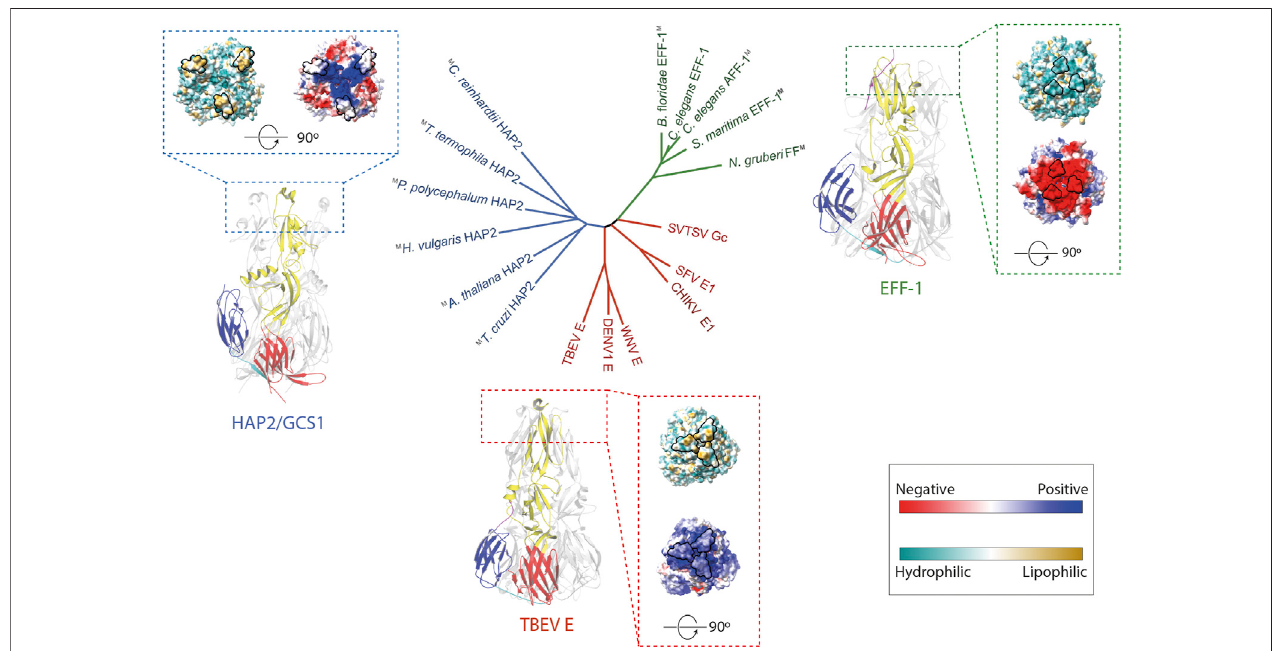
FIGURE1| TheFusexinsuperfamily.Ribbonrepresentationofthefusionproteintrimers C.elegans EFF-1(PDB4OJC;Pérez-Vargasetal.,2014),TBEVE(PDB1URZ; Bressanellietal.,2004),and A.thaliana HAP2(PDB5OW3;Fedryetal.,2018)withdomainsI,II,IIIcoloredbyred,yellow,blue,respectively.Surfacerepresentationoftrimers viewed from the membrane was displayed. The surface is colored according to the electrostatic potential on a scale from -5 to 5 kT/e (calculated with APBS, Jurrus et al., 2018) from red (negative) to blue (positive). Solvent-excluded surfaces of trimers are colored based on molecular lipophilicity potential maps, ranging from dark cyan (hydrophilic) to dark gold (lipophilic). Proposed fusion loops at the tip of domain II are contoured in black. In the center, an unrooted tree inferred using a distance matrix extracted from (Valansi et al., 2017). Colors are HAP2/GCS1, blue; FF proteins, green; class II viral fusogens, red. M superscript represents models.